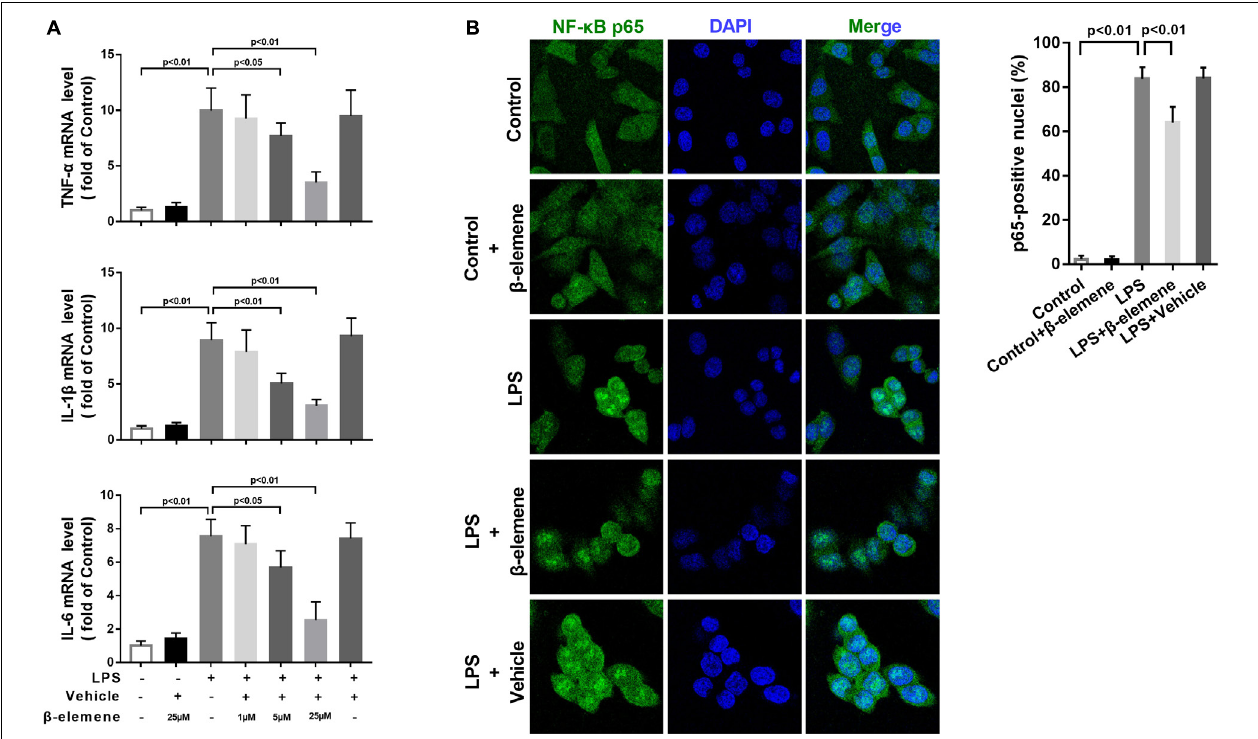
FIGURE 1 | β -Elemene suppressed LPS-induced inflammation in BV-2 cells. (A) β -Elemene suppressed LPS-induced upregulation of mRNA expressions of TNF- α [F(6, 21) = 23], IL-1 β [F(6, 21 = 26.4)], and IL-6 [F(6, 21 = 27.68)]. GAPDH was used as a loading control. (B) β -Elemene reduced the NF- κ B translocation from the cytosol to the nucleus. F(4, 15) = 244.6. n = 4. Two-way or one-way ANOVA revealed a significant difference at p <